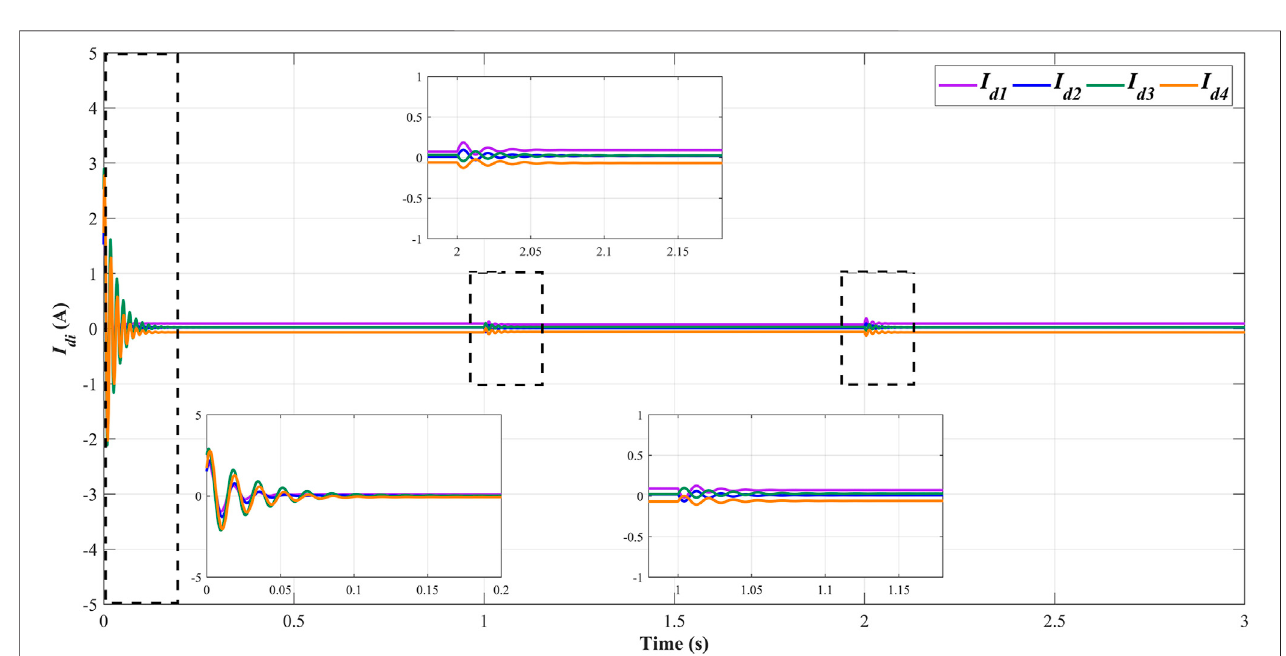
FIGURE 6 | Time evolution of the d -component of currents of interconnecting lines.